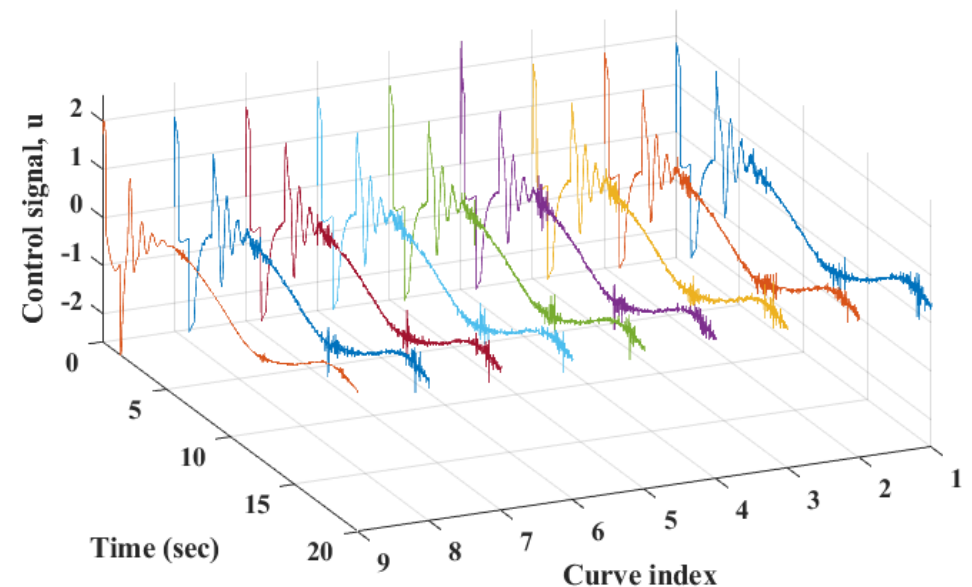
Figure 3. The control signals with curve indices from 1 to 9 represent LESO, NLESO types I, II, III, IV(a), IV(b), V, and VI, and NHOESO, respectively of Table 1.